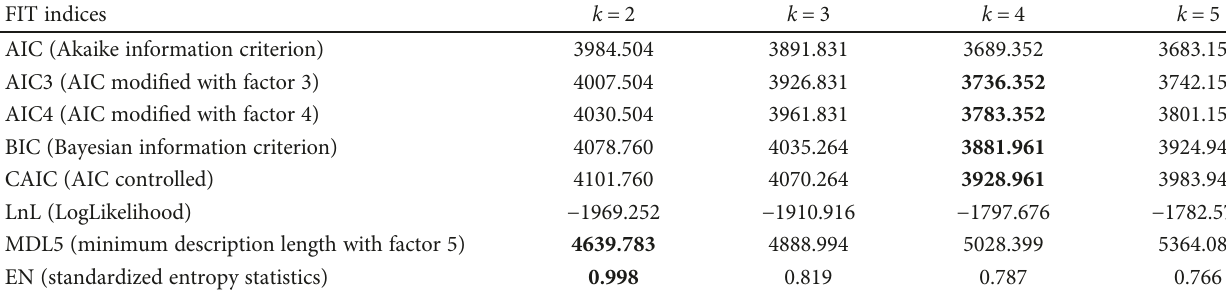
Table 7: Indices FIT. Criteria for model choice.